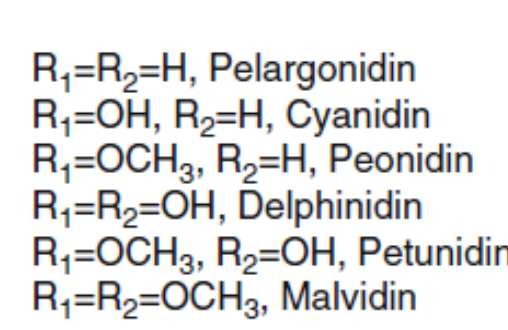
Figure 2. Anthocyanidin structures.